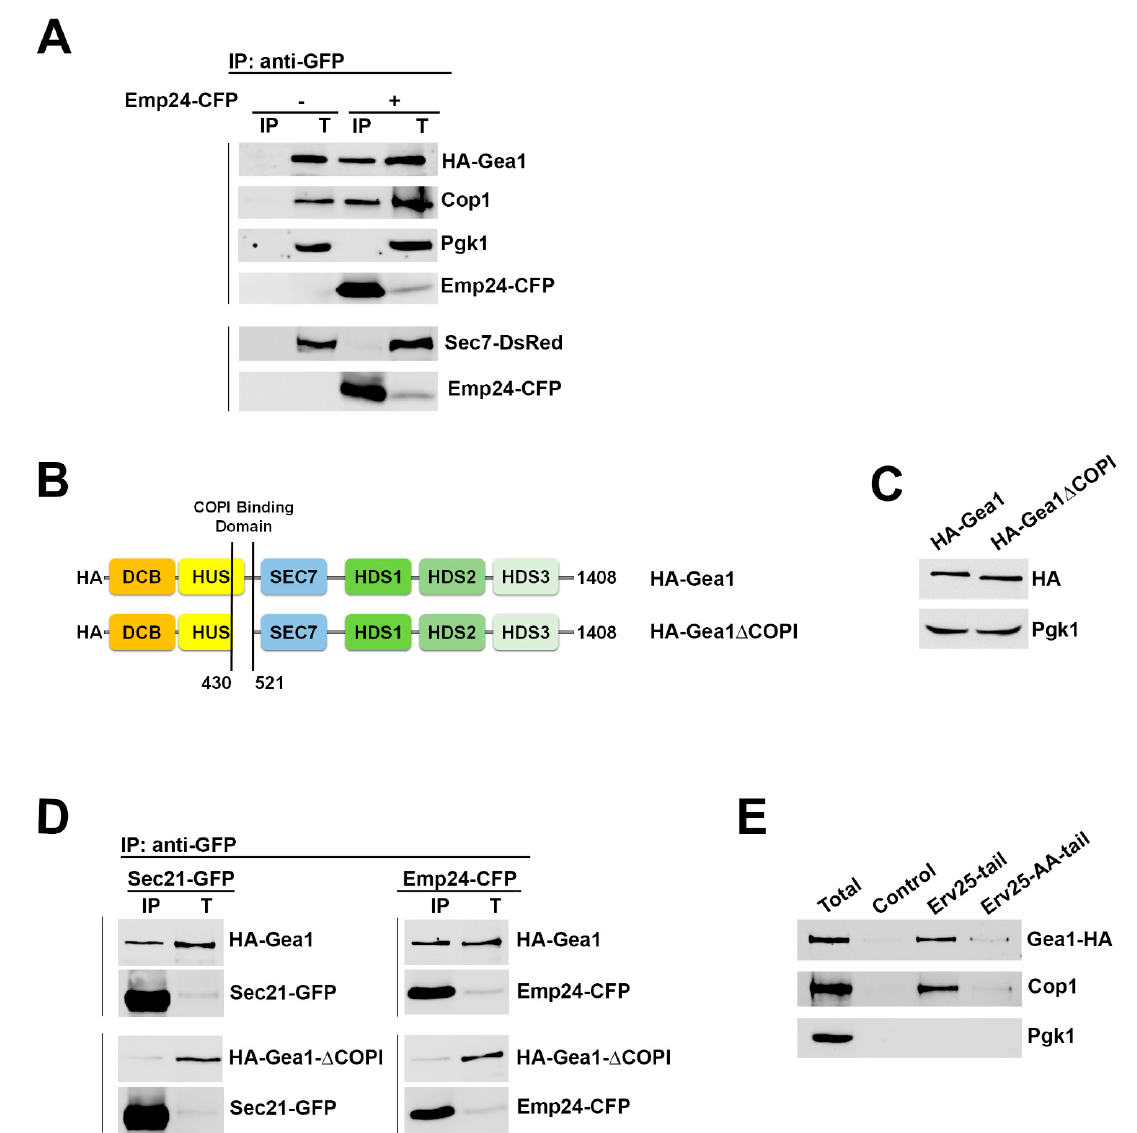
Figure 2. The p24 complex specifically associates with the ArfGEF Gea1 through the COPI coat. ( A ) Emp24-CFP specifically binds the early Golgi-localized ArfGEF HA-Gea1 and the COPI coat subunit Cop1 but not the late Golgi-localized ArfGEF Sec7-dsRed. Native coimmunoprecipitation assay between the p24 complex subunit Emp24-CFP and HA-Gea1, Cop1 or Sec7-DsRed. S13 enriched-Golgi fractions of wild-type cells expressing the indicated tagged proteins were immunoprecipitated with anti-GFP antibody, followed by immunoblotting. Total (T) represents a fraction of the solubilized input material. ( B ) Scheme of full-length HA-Gea1 and deletion construct of HA-Gea1p (HA-Gea1 ∆ COPI) lacking residues 434–521, a region involved in direct binding to the COPI coat [16]. DCB, dimerization and cyclophilin binding domain; HUS, homology upstream of Sec7 domain; Sec7, guanine nucleotide exchange factor domain; HDS1, HDS2, HDS3, homology downstream of Sec7 domains. ( C ) HA-Gea1 ∆ COPI is expressed to the level of the full-length HA-Gea1. Protein expression levels of each construct were analyzed by Western blot of whole cell extracts. Pkg1 serves as a loading control. ( D ) The lack of the COPI coat binding region (434–521) [16] in HA-Gea1 ∆ COPI prevents its efficient association to the p24 complex. S13 enriched-Golgi fractions of wild-type cells expressing indicated tagged proteins were immunoprecipitated with anti-GFP antibody, followed by immunoblotting. Total (T) represents a fraction of the solubilized input material. ( E ) The p24 proteins interact with Gea1 through COPI binding. Synthetic peptides corresponding to the cytoplasmic tail of the p24 protein Erv25 (KNYFKTKHII) or to Erv25-AA with aromatic residues replaced by alanines (KNAAKTKHII) were coupled to thiopropyl-Sepharose beads. These peptide-bound beads and empty beads (Control) were incubated with cytosol from a wild-type strain expressing HA-Gea1. Bound material was resolved by SDS-PAGE and analyzed by